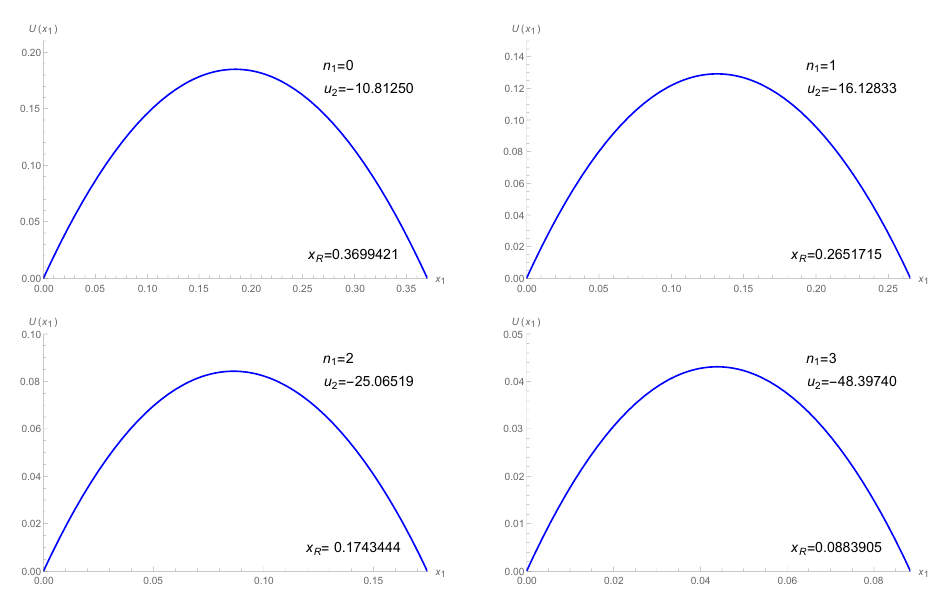
Figure 1 . ( f 0 ; f 1 ; f 2 ; f 3 ; c 1 ; c 2 ; k ) = (2 ; 1 ; 1 ; 2 ; 4 ; 1 ; 1) and u 1 =